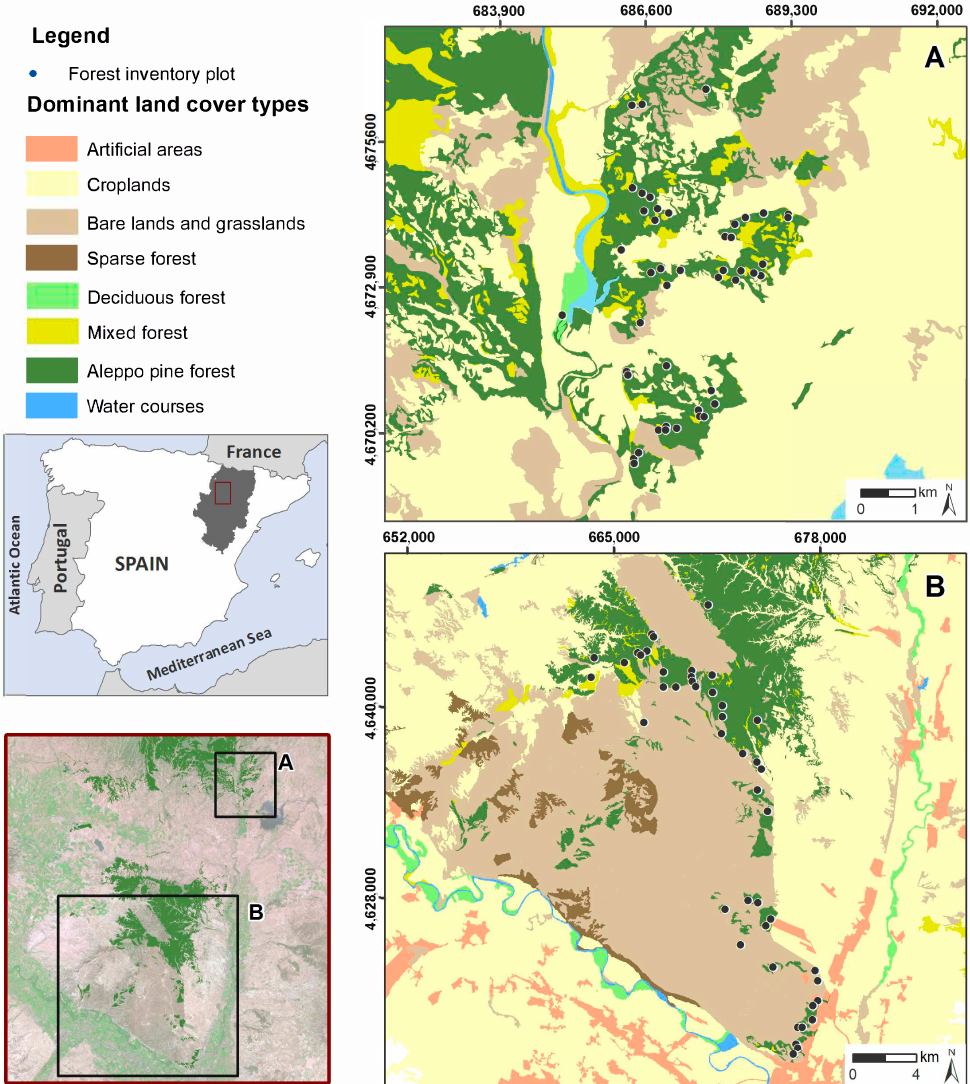
Figure 1. Study area. Land cover types and location of 83 forest inventory plots. High spatial resolution orthophotography of the Spanish National Plan for Aerial Orthophotography [54] is used as backdrop. Coordinate System: ETRS89 UTM Zone 30 N.